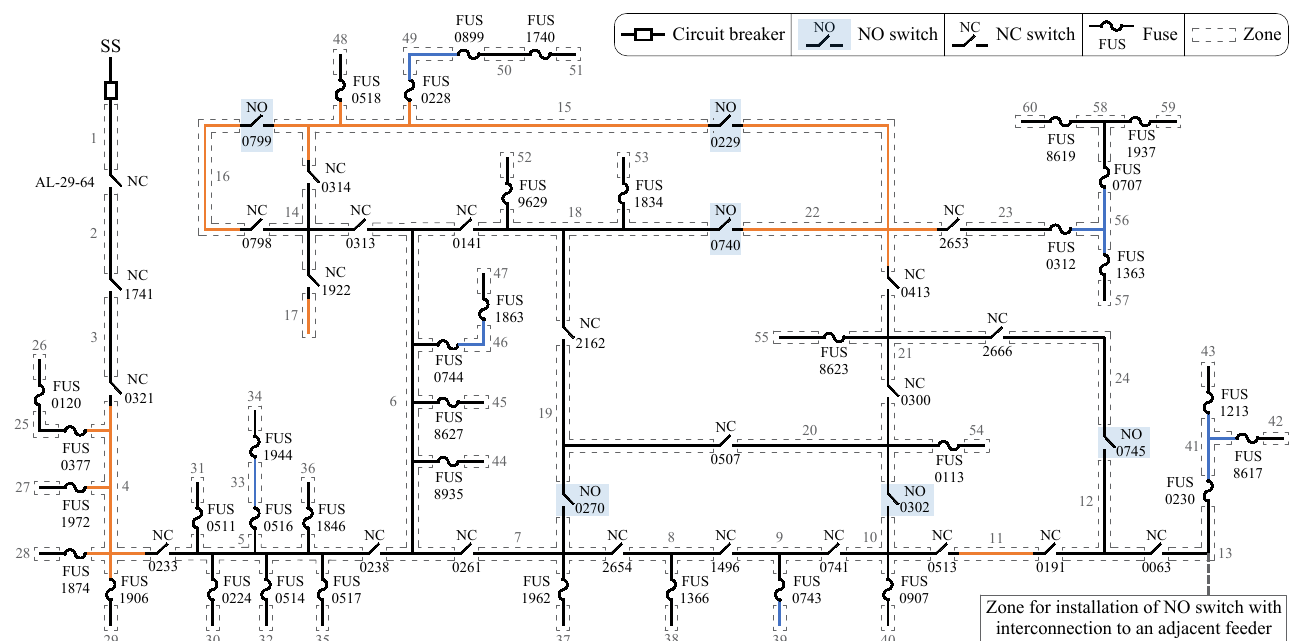
Figure 8. Zone diagram of the real distribution feeder used as example.